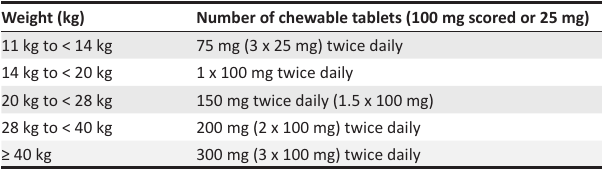
TABLE 1-A1: Raltegravir chewable tablets. Weight